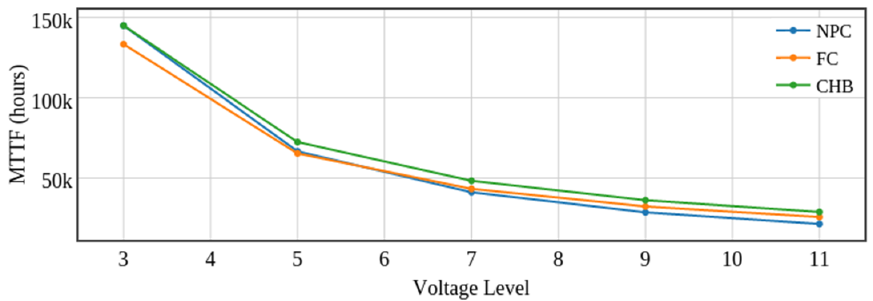
Figure 5. The approximate MTTF for different voltage levels.